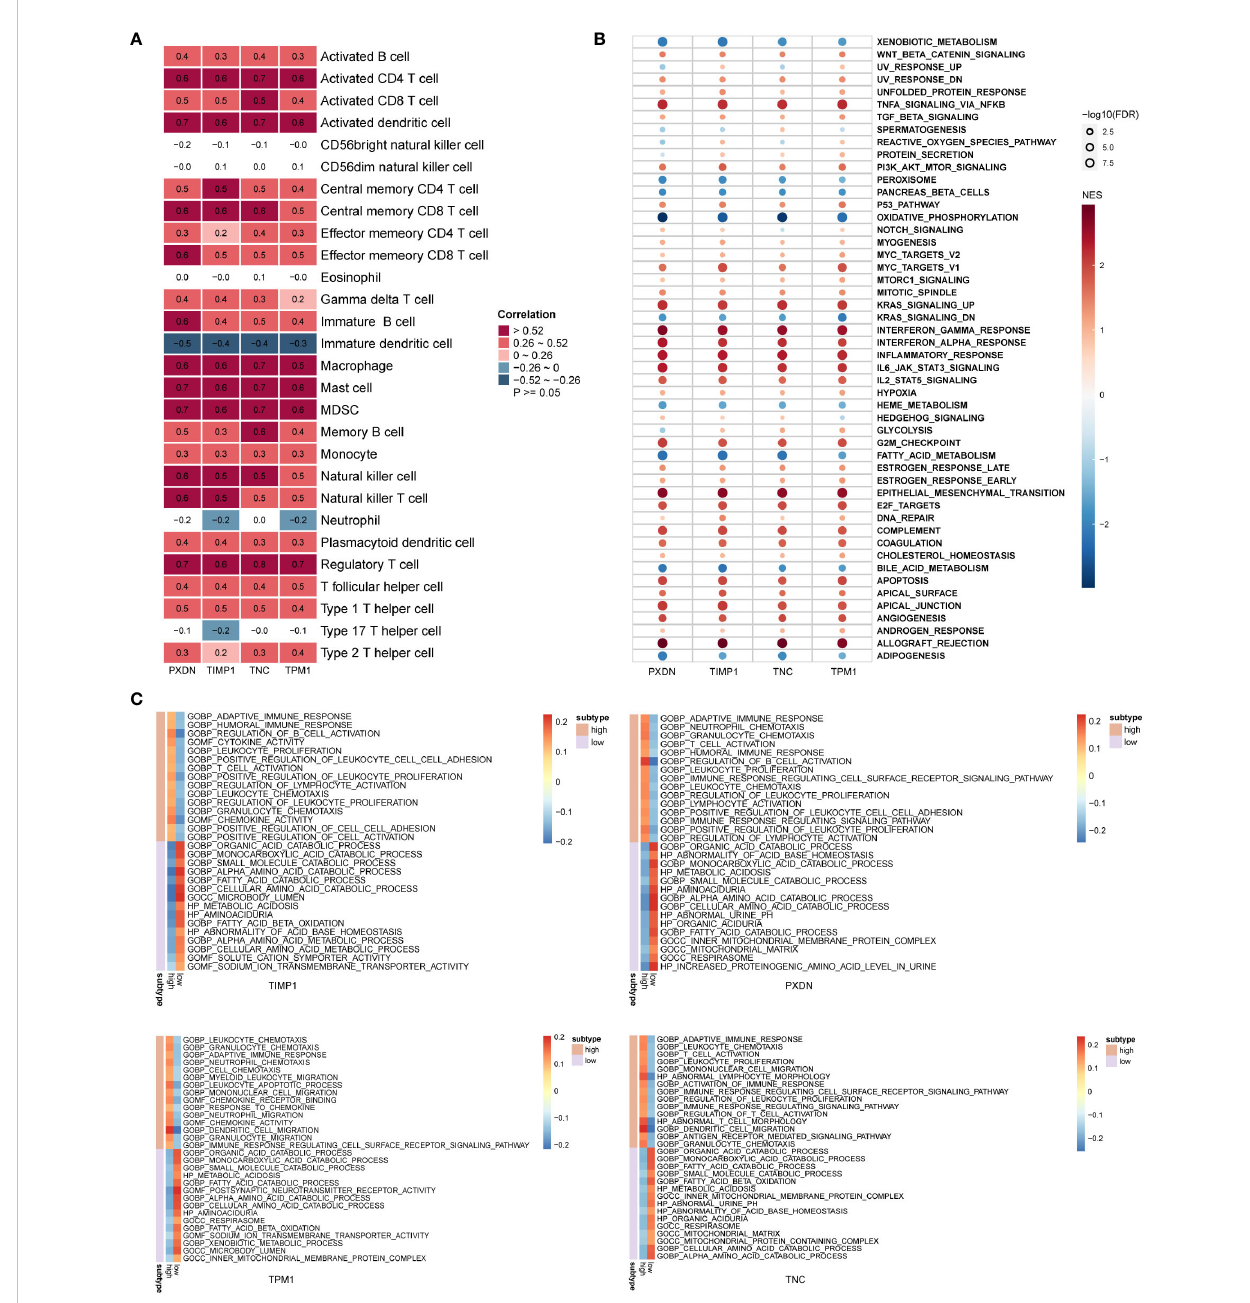
FIGURE 7 Biological function enrichment of diagnostic markers. (A) Heatmap of the correlation between diagnostic markers and immune cells. (B, C) GSEA enrichment analysis when the reference gene sets are hallmark gene sets (B) and ontology gene sets (C)